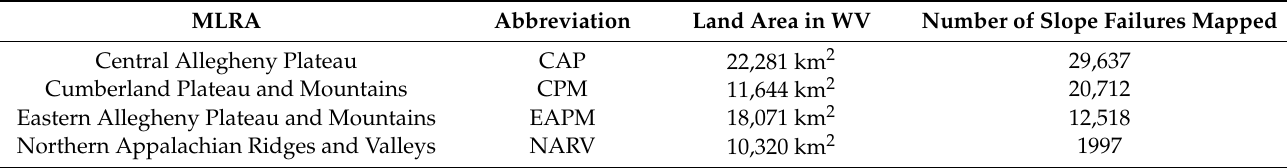
Table 1. MLRA land areas, abbreviations used in this study, and number of mapped slope failure incidence points. Note that a statewide dataset of incidence points is not yet available since LiDAR data collection is not yet